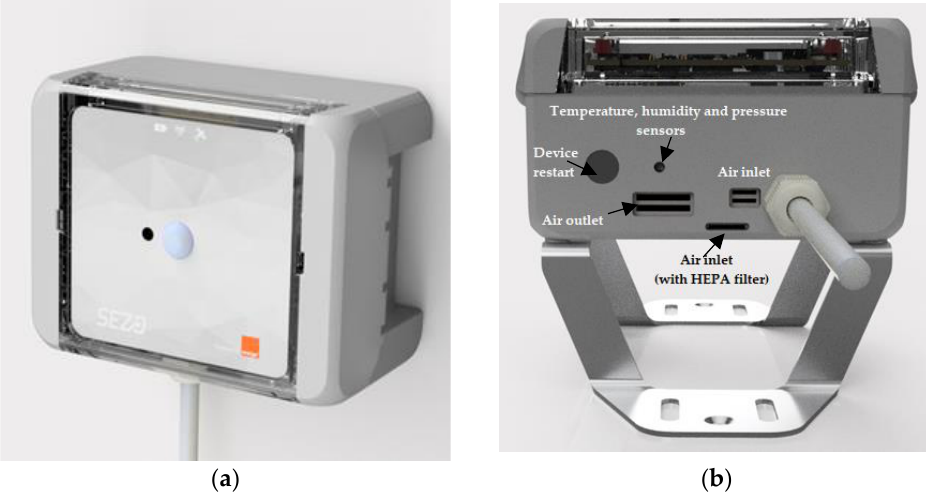
Figure 3. General appearance of the SEZO AM device in polycarbonate housing [41] ( a ) and device without housing, presenting the air inlet/outlet ( b ).